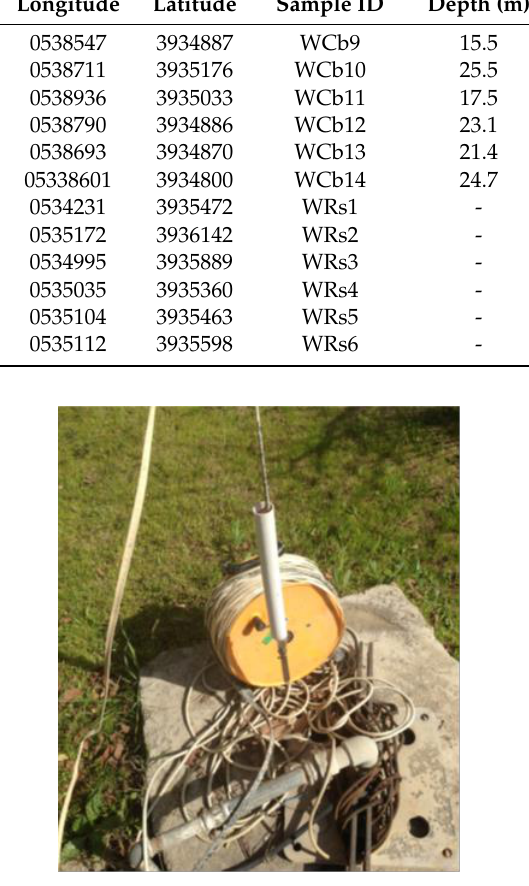
Figure 7. Local cylinder fixed with electrical sounder.